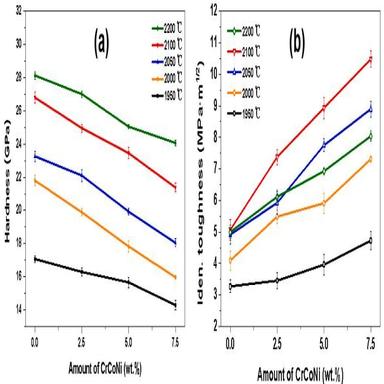
Mechanical properties of CCN/SiC, (a) and (b) are the Vicker's hardness and indentation toughness of SiC-CCN composites, respectively.